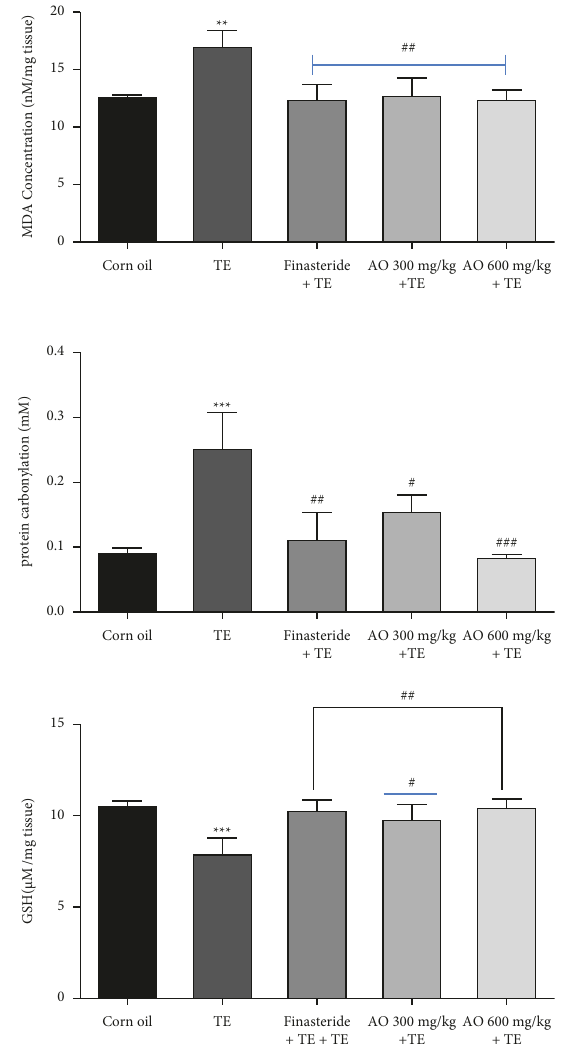
Figure 3: GSH, MDA, and protein carbonyl level of prostate gland tissue, and the values are expressed as mean ± SEM ( n � 3 animals/ group). ### p < 0 . 001, ## p < 0 . 01, and # p < 0 . 05 vs. testosterone, ∗∗∗ p < 0 . 001 and ∗∗ p < 0 . 01 vs. control.